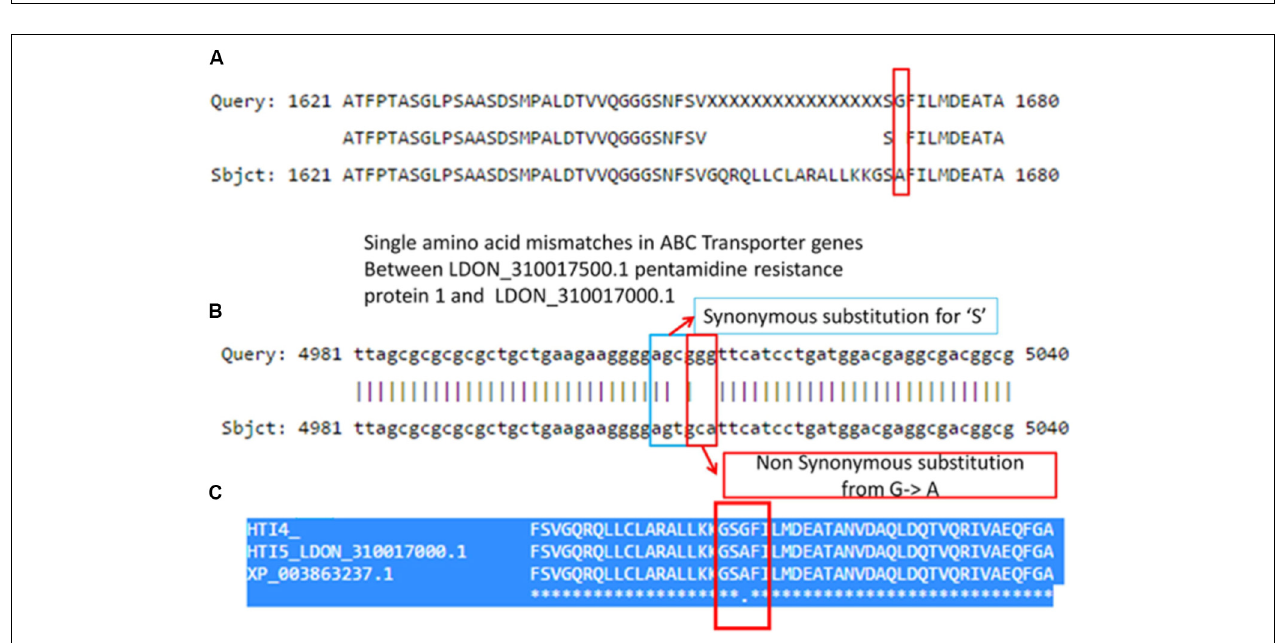
FIGURE 5 | Synonymous and non-synonymous substitution in early and late passages leading to altered ABC transporter genes in chromosome 31. (A) A pair wise comparison between the protein coding genes in HTI4 and HTI5 showing single amino acid mismatches. (B) Nucleotide comparison in two genes indicates few substitutions, out of which the first one is a synonymous substitution and the second one is a non-synonymous substitution. A comparison between HTI4, HTI5 and Genbank strain (C) clearly indicates change of G–A in late passage same as the reference genome.